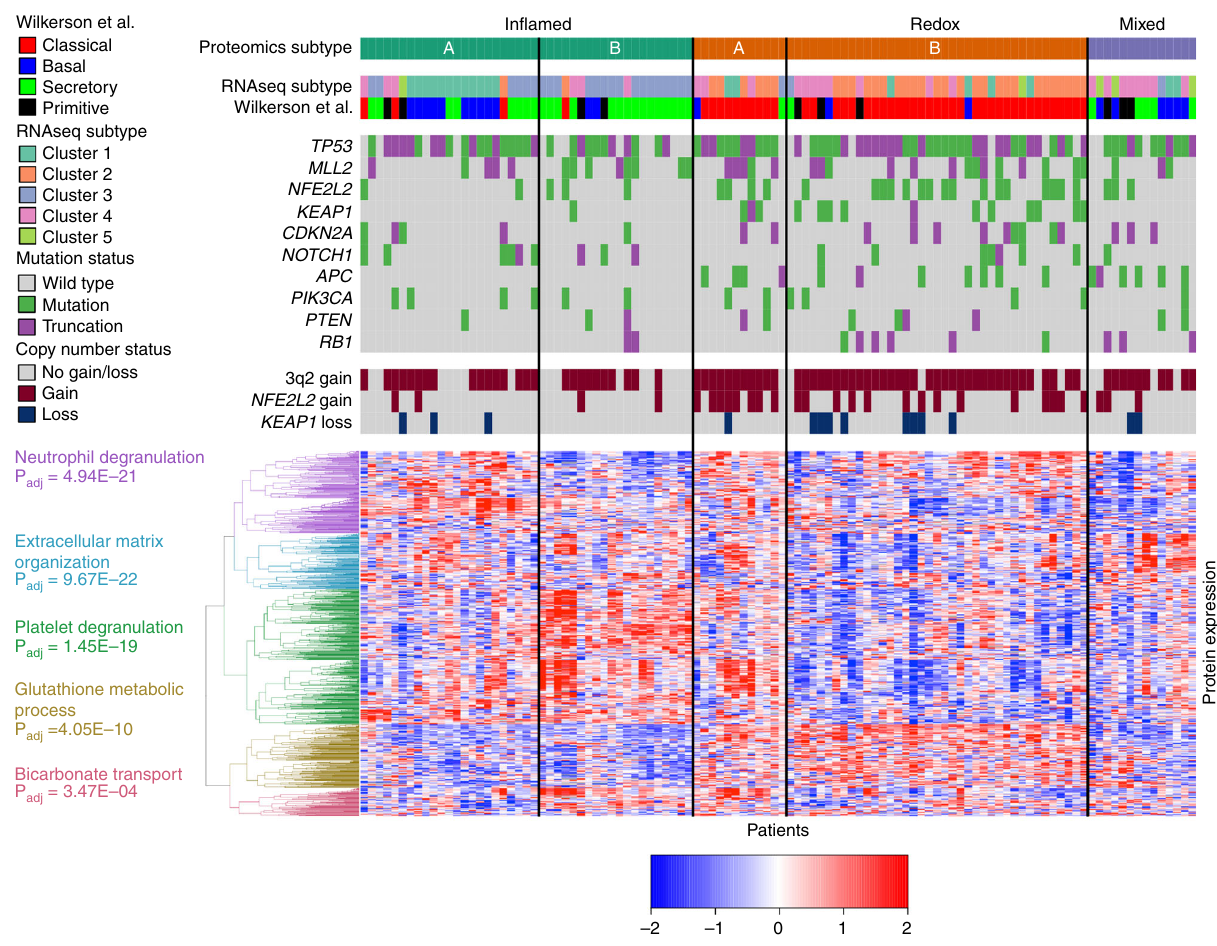
Fig. 1 Identi fi cation of three proteomic subtypes of SCC. One hundred eight patient tumors are displayed as columns, and the 1000 most variable proteins by absolute median deviation are displayed as rows. The patient tumors were organized by consensus clustering into fi ve clusters corresponding to three biological subtypes (In fl amed, Redox, and Mixed). There is partial concordance with the Wilkerson et al. mRNA-based classi fi ers of these same samples, but the primitive group is not recapitulated. Mutation status and copy alterations of commonly mutated SCC genes/loci are shown directly above the heatmap. We identi fi ed fi ve groups of proteins from the heatmap clustering. We took the proteins from each group and searched against GO: Biological Processes to yield a list of pathways (Enrichr). The topmost enriched pathway with P adj ≤ 0.05 was used to label the protein clustering in the heatmap. The mean transcript-protein correlations for these pathways using matched RNAseq expression were: 0.46 for neutrophil degranulation, 0.56 for extracellular matrix organization, 0.35 for platelet degranulation, 0.64 for glutathione metabolic process, and 0.60 for bicarbonate